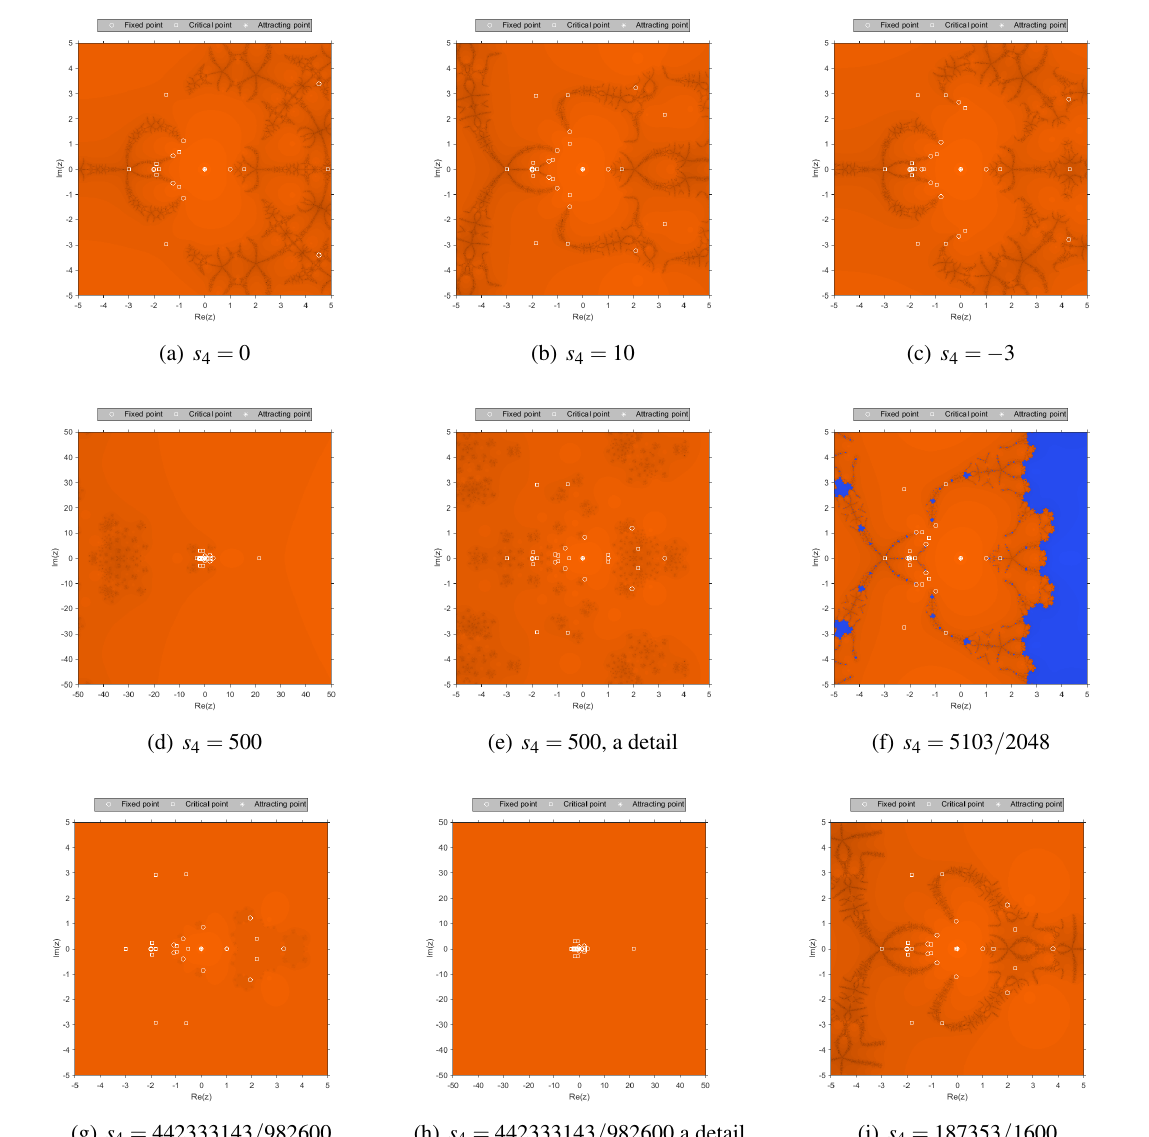
Fig. 6 Dynamical planes with stable behavior for m =